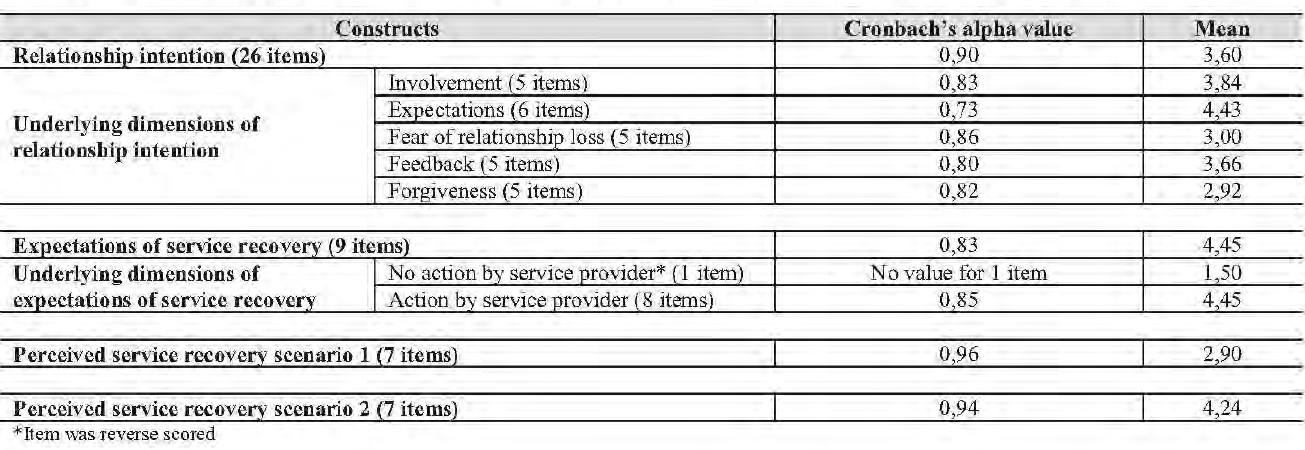
Table 2: Cronbach's alpha coefficient values, underlying dimensions of the measurement scales and mean scores Constructs